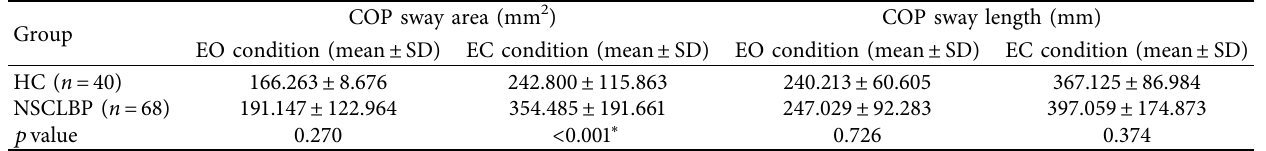
Table 2: COP sway variables under 2 conditions contracting the two groups.